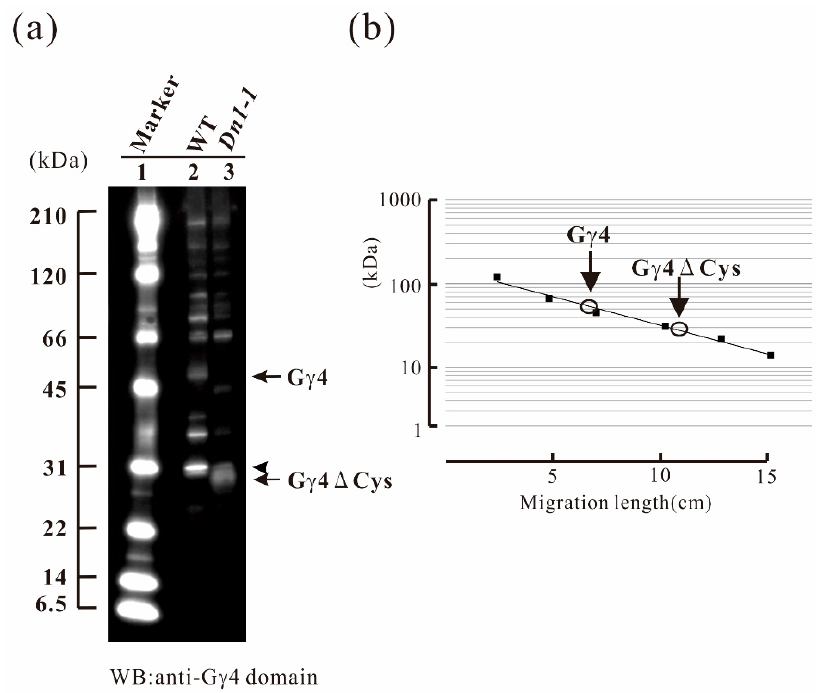
Figure 2. Immunological study of the G γ 4 candidates in leaf sheath of wild type (WT) and Dn1-1 . ( a ) Plasma membrane protein fractions of WT and Dn1-1 (10 μ g) were used for western blot analysis using anti-G γ 4 domain antibody. Lane 1 contains molecular weight markers. The G γ 4 candidate (indicated by an arrow) was detected as a broad band with a molecular weight of approximately 55 kDa in WT (lane 2). The G γ 4 Δ Cys candidate (indicated by an arrow) was detected as a broad band with a molecular weight of approximately 27 kDa in Dn1-1 (lane 3). An arrowhead indicates non-specific bands found in both WT and Dn1-1 . ( b ) The molecular weights of G γ 4 and G γ 4 Δ Cys candidates were estimated using molecular weight marker as the standard.